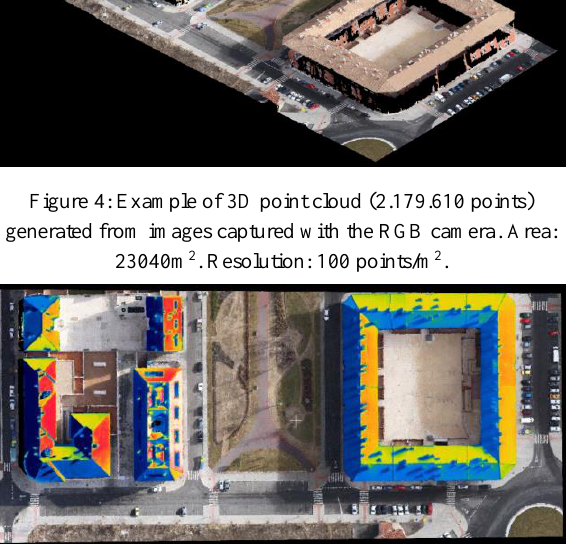
Figure 5: Previous 3D point cloud (2.179.610 points) with the thermographic texture mapped on the